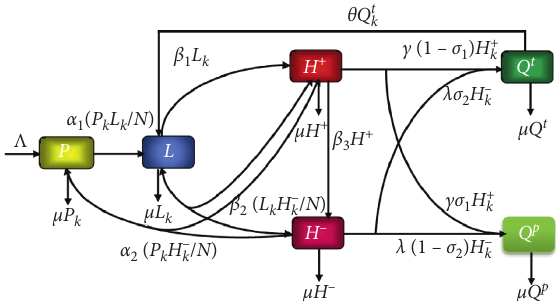
Figure 1: The flow between the five compartments PLH + H − Q t Q p